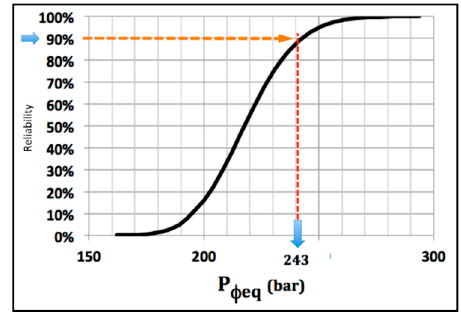
Figure 4. Statistical distribution of P ∅ eq .